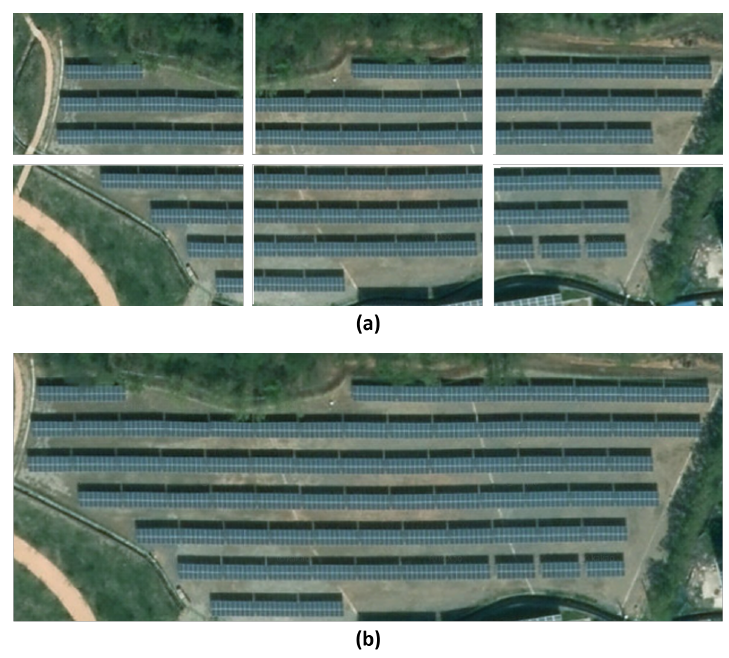
Figure 6. ( a ) Aerial images captured by drone; and ( b ) image of PV power station after image stitching. The segmented image I ROI as shown in Figure 7b is smoothed to remove noise before inputting it to the canny edge detection algorithm for edge detection. After edge detection, we find contours in the edge image I e (see Figure 7c) and filter out contours below a certain threshold area. Bounding boxes (see the red boxes in Figure 7d) are generated for each of the remaining contours. The left and right vertical lines of the bounding box are selected as the start (marked blue in Figure 7e) and end (marked red in Figure 7e) path points for each contour. The obtained waypoints are input to the drone GCS and set to perform the automatic flight path.